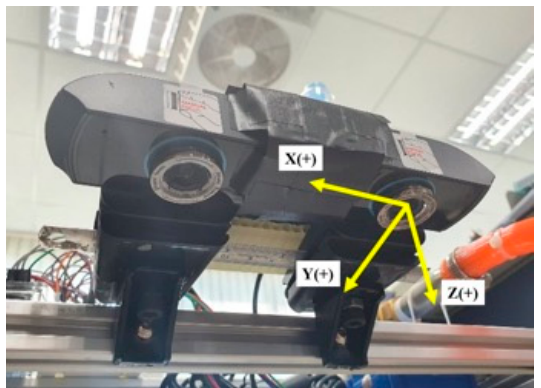
Figure 17. The coordinate system of the binocular camera.